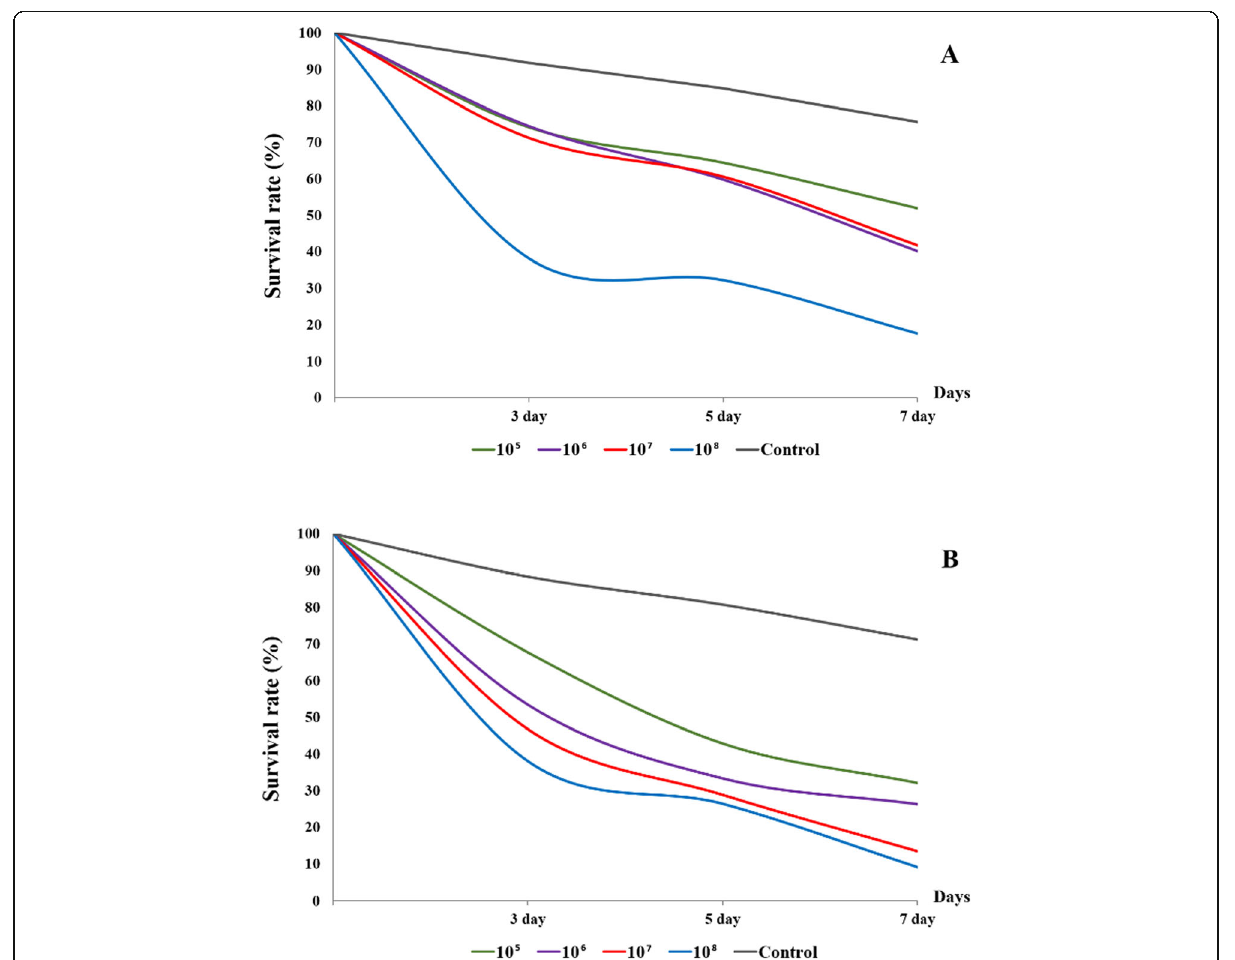
Fig. 2 Survival rate of Tetranychus urticae after application of BGF14 ( a ) and BCA32 ( b ) isolates of Beauveria